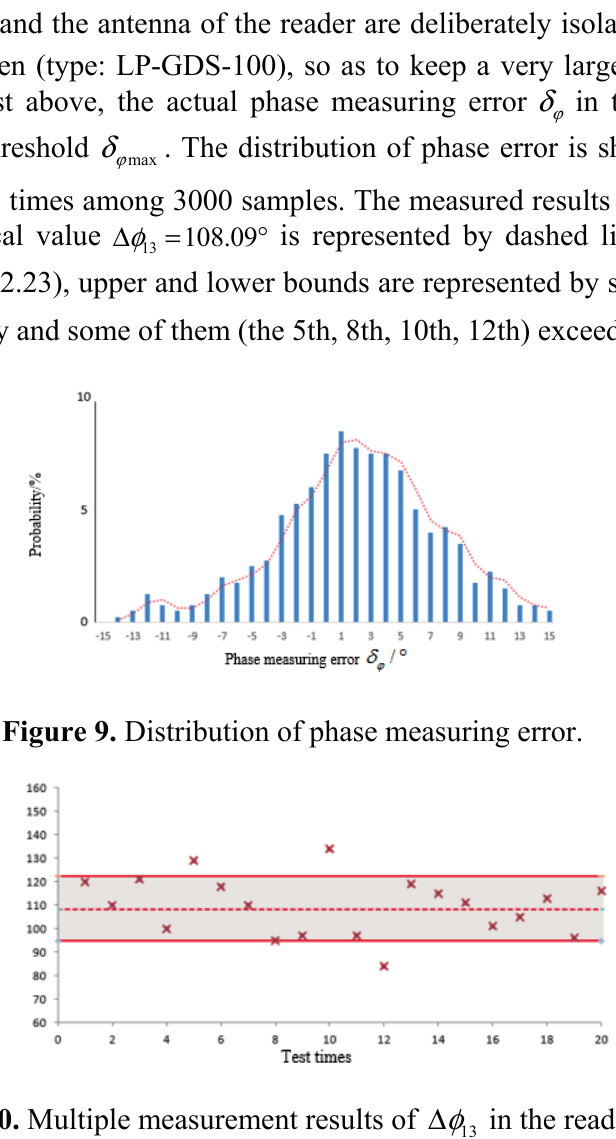
Figure 8. Relation between